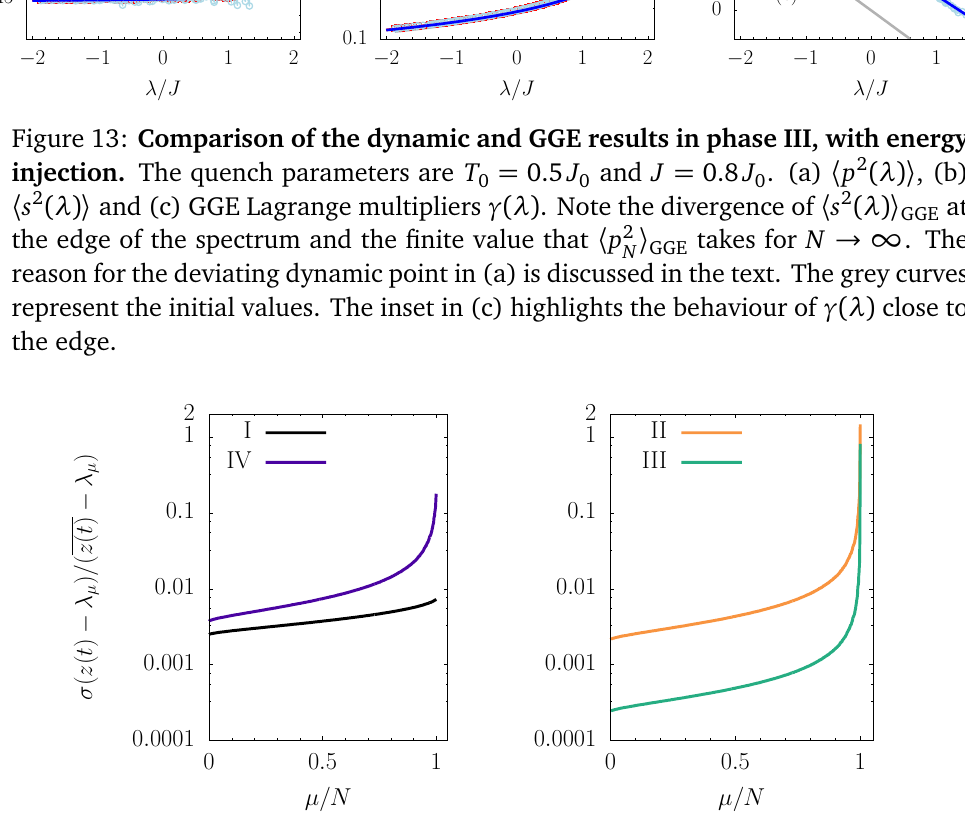
Figure 14: Temporal fluctuations of the mode frequencies in all phases of the phase diagram in a system with N = 1024. The temperature of the initial conditions = 1.5 J = 0.5 J are T in phases I and II and T in phases III and IV. The post-quench 0 0 0 0 interaction is J = 0.4 J (phase I), J = 1.7 J (phase II), J = 1.2 J 0 0 J = 0.5 J (phase 0